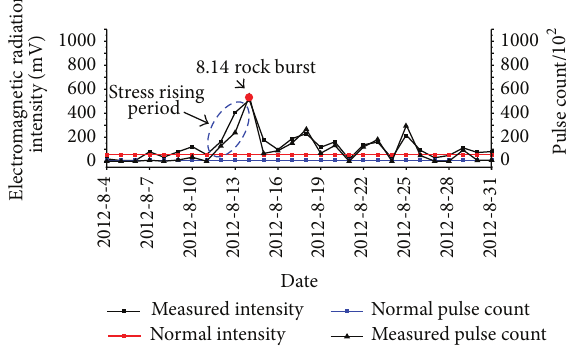
Figure 4: Electromagnetic radiation signal